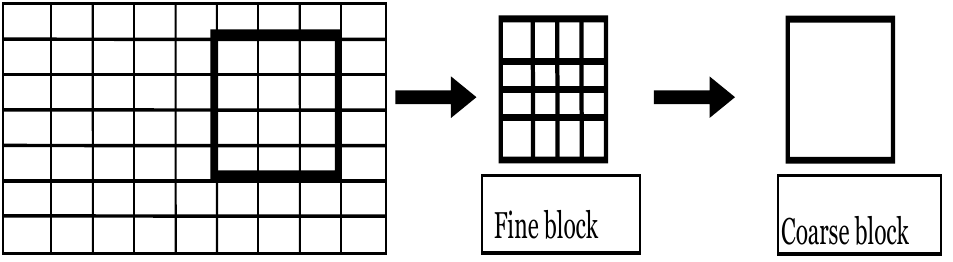
Figure 3. Local method for upscaling